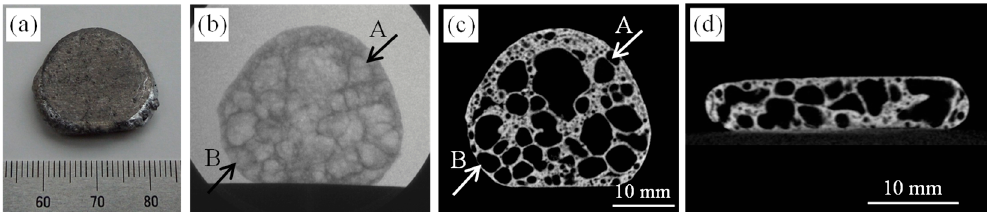
Figure 3. ( a ) Aluminum foam obtained without press forming. ( b ) X-ray transmission image of foam (a). ( c ) X-ray CT image corresponding to foam (b). ( d ) Cross-sectional X-ray CT image of foam (a) in thickness direction.